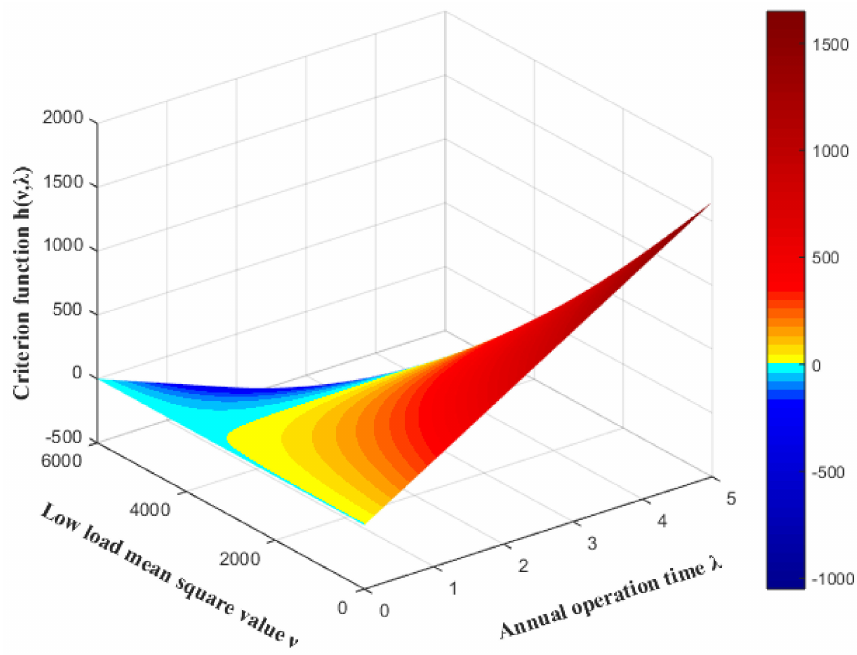
Figure 11. Criterion function h ( ν , λ ) with the change of index ν and λ